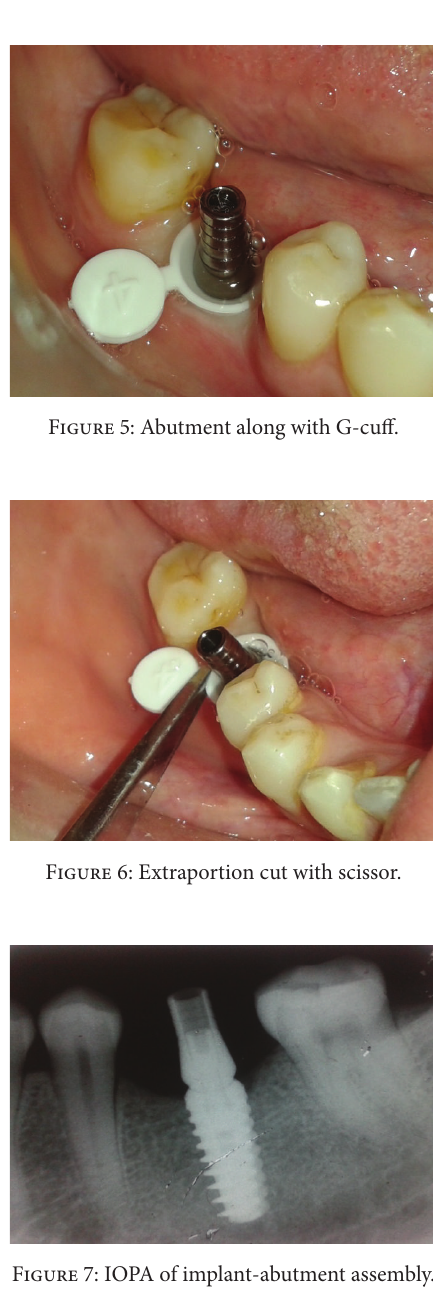
Figure 11: Emergence profile of crown.